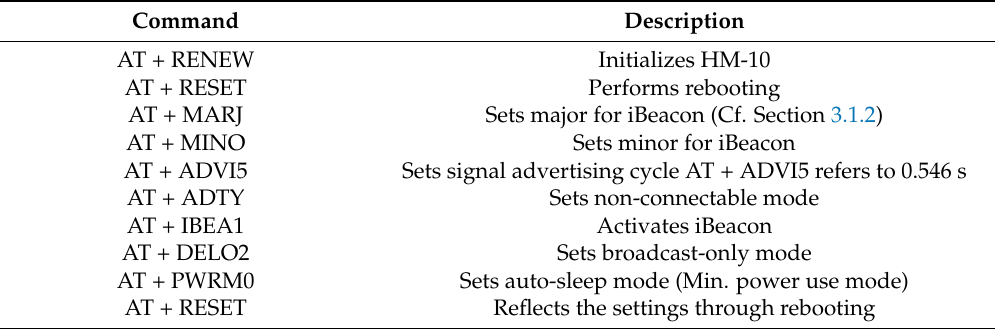
Table 5. HM-10 Activation Commands by HM-10. Table 5. HM-10 activation commands by